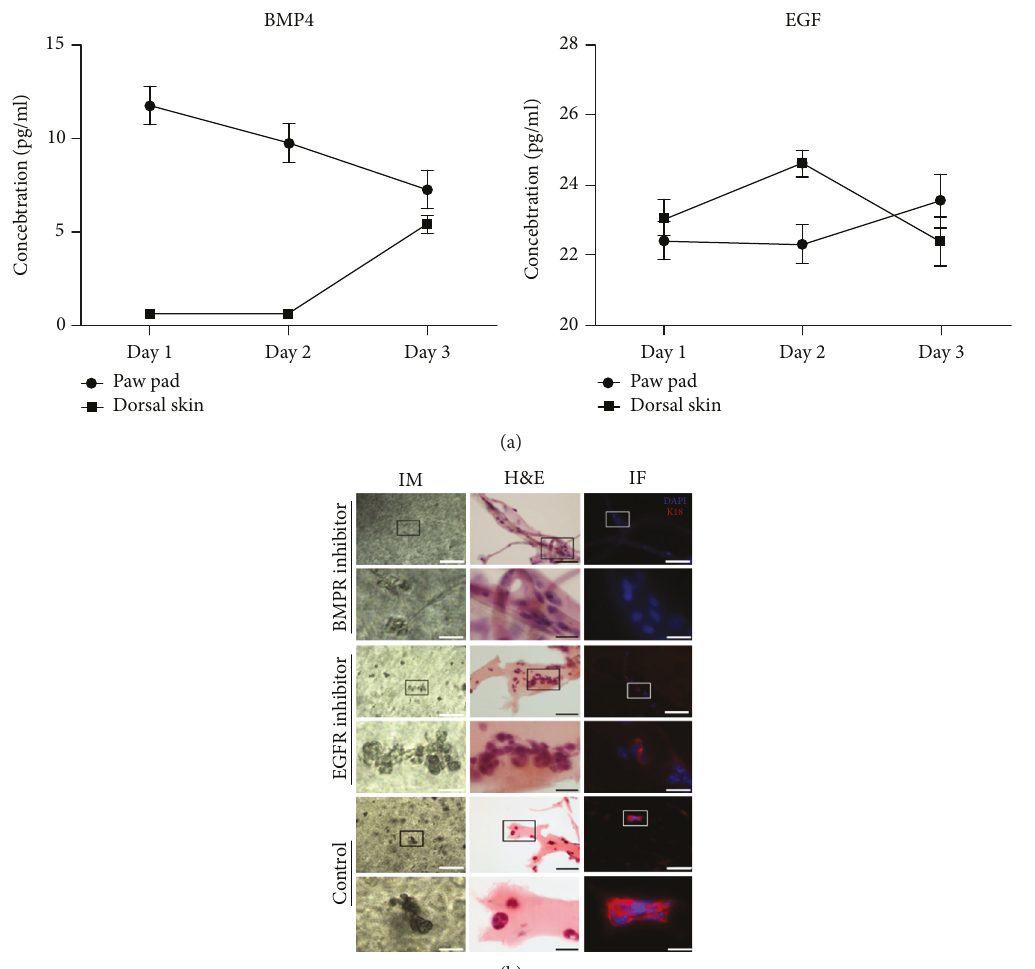
Figure 4: Detection of key soluble morphogens in the system of sweat gland morphogenesis and the impact of BMP receptor inhibitor and EGF receptor inhibitor on sweat gland development in vitro. BMP4 and EGF demonstrated sharped di ff erence in the medium of the sweat gland organogenesis system. BMP receptor inhibitor could block the formation of sweat gland in this system, while EGF receptor inhibitor signi fi cantly reduced the expression of K18. (a) The variation tendency of BMP4 and EGF in the medium of system. The error bar meant the standard error of BMP4 and EGF concentrations in di ff erent systems at di ff erent time points. (b) The impact of BMP receptor inhibitor and EFG receptor inhibitor on sweat gland morphogenesis. In comparison with the control group, EGF receptor inhibitor signi fi cantly reduced the expression of K18, but glandular structure was still observed. BMP receptor inhibitor completely blocks the expression of K18, and no glandular structure was observed. All the nuclei were counterstained with DAPI (DAPI: blue; K18: red; bars = 200 μ m and 50 μ m; K18: cytokeratin 18; IM: light microscope; H&E: hematoxylin-eosin staining; IF: immuno fl uorescence